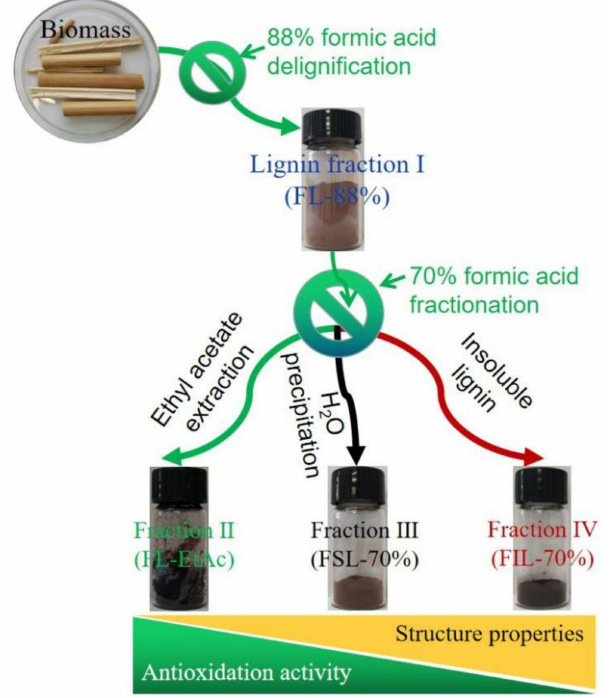
Figure 1. Scheme of lignin fractions preparation from P. australis biomass by sequential two-step formosolv